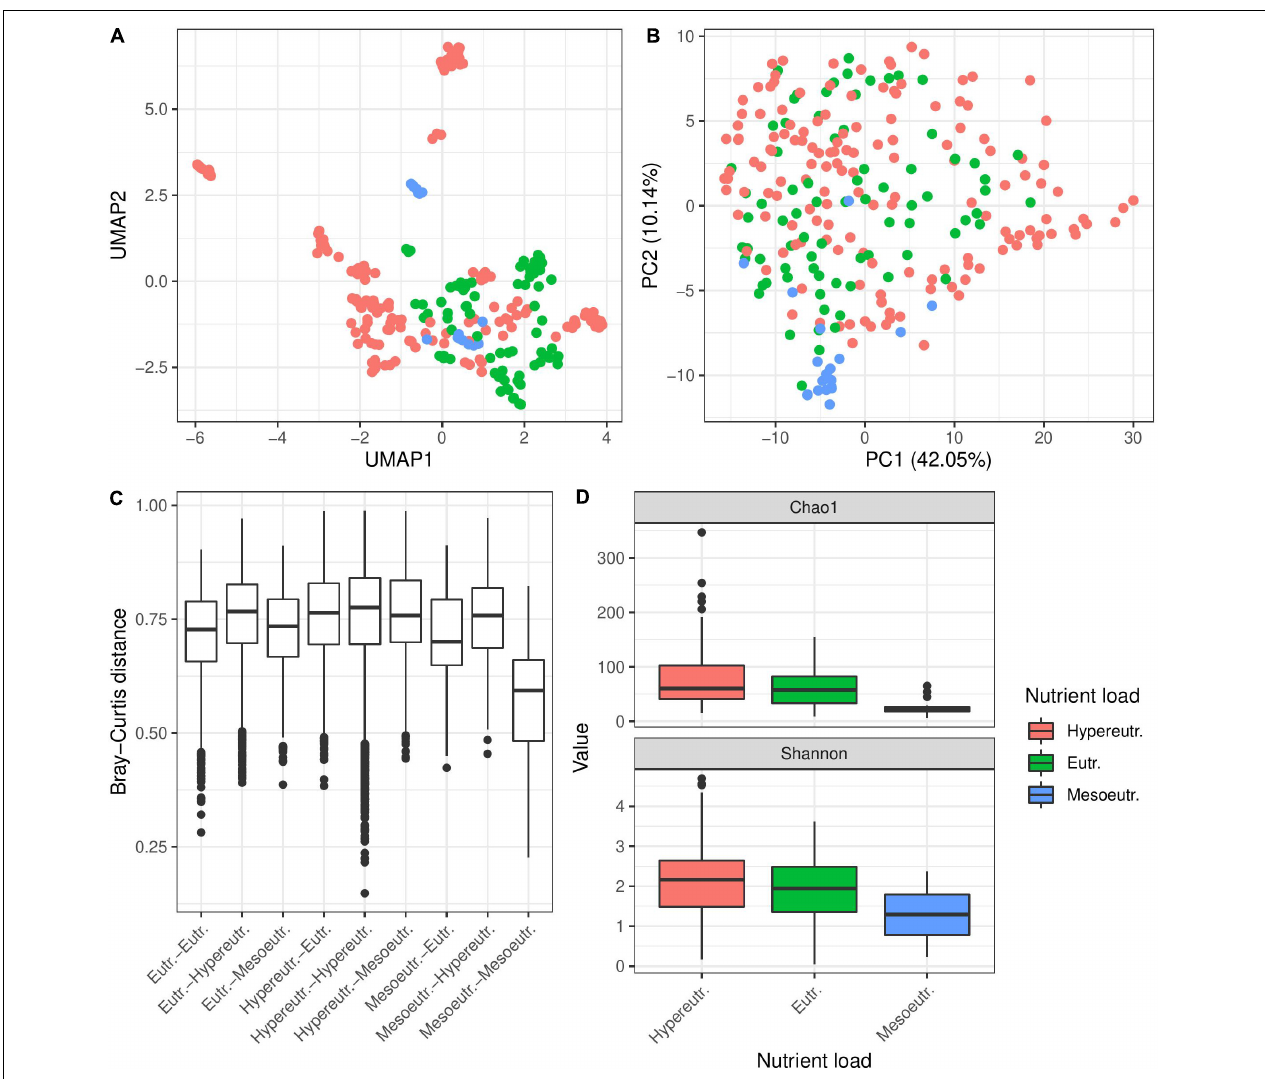
FIGURE 4 | Influence of trophic state of water body on bacterial colonization in Hydra . UMAP plots (A) and PC ordination (B) of β -diversity (Bray–Curtis) show separation of the samples by trophic state of the water body. Separation of microbial communities by trophic state is supported by univariate PERMANOVA ( R 2 = 0.05, p ≤ 0.001 with 999 permutations, Table 2 ) but not in multivariate PERMANOVA ( R 2 = 0.04, p = 0.2570, with 999 permutations, PopID as random effect, all other factors as cofactor). Bray–Curtis dissimilarities (C) are smallest between mesoeutrophic water bodies, while dissimilarities between all other pairs of trophic states are higher. This indicates that Hydra ’s microbiota is more constrained in diversity in mesoeutrophic water bodies as those in standing water bodies. In support of this result, α -diversity is significantly smaller in mesoeutrophic water bodies than in eutrophic and hypereutrophic water bodies (D) in univariate linear models ( R 2 = 0.070, p ≤ 0.2E-4, on Shannon index). However, multivariate models do not support the influence of trophic state on bacterial diversity (linear mixed model on Shannon index with population as random effect, all other factors as cofactor, X 2 = 4.385, p =